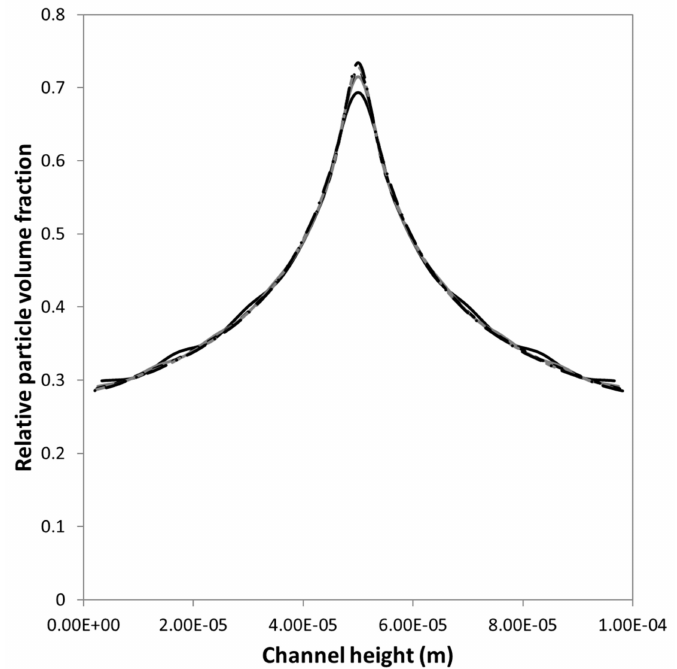
Figure A3. Grid refinement study for case 3. The relative particle volume fraction versus the channel height, measured 2.5 cm from the channel entrance. The grid cell number of the channel height is changed: 15 grid cells (black solid line); 19 grid cells (grey solid line); 21 grid cells (black dashed line); 23 grid cells (grey dashed line) and 27 grid cells (black dashed-dotted